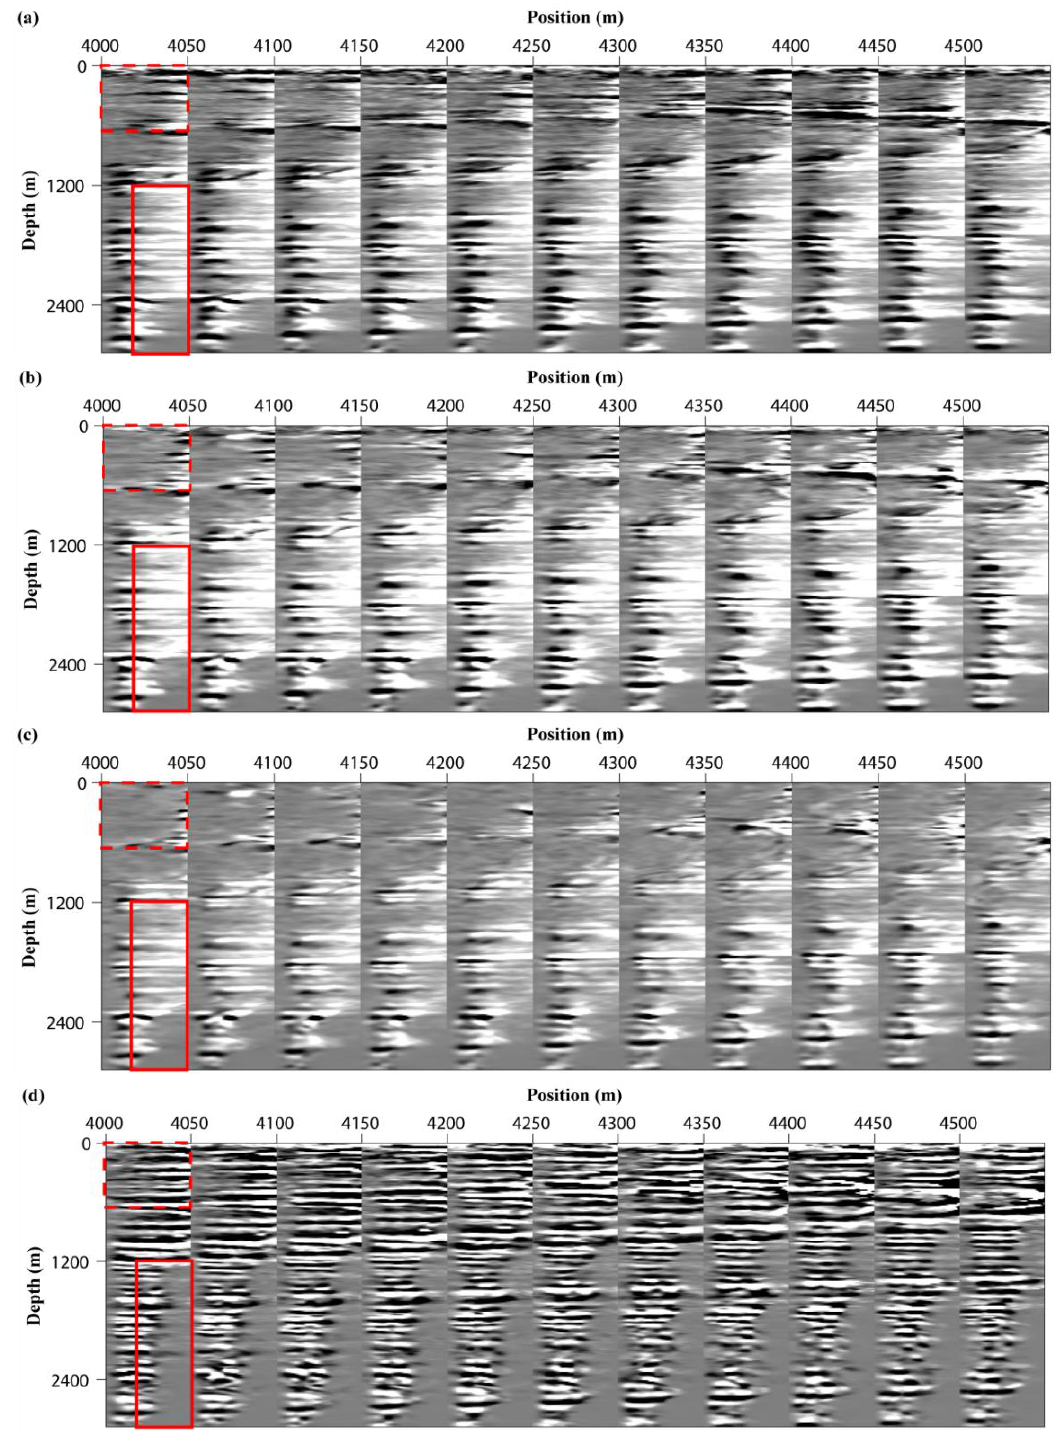
Figure 6. Comparison of angle gathers generated by using ( a ) Method 1, ( b ) Method 2, ( c ) Method 3 and ( d ) Method 4. The true velocity model is used for migration. The reflection angle from left to right is 0 to 50°. All four images are regularized to the same amplitude scale.